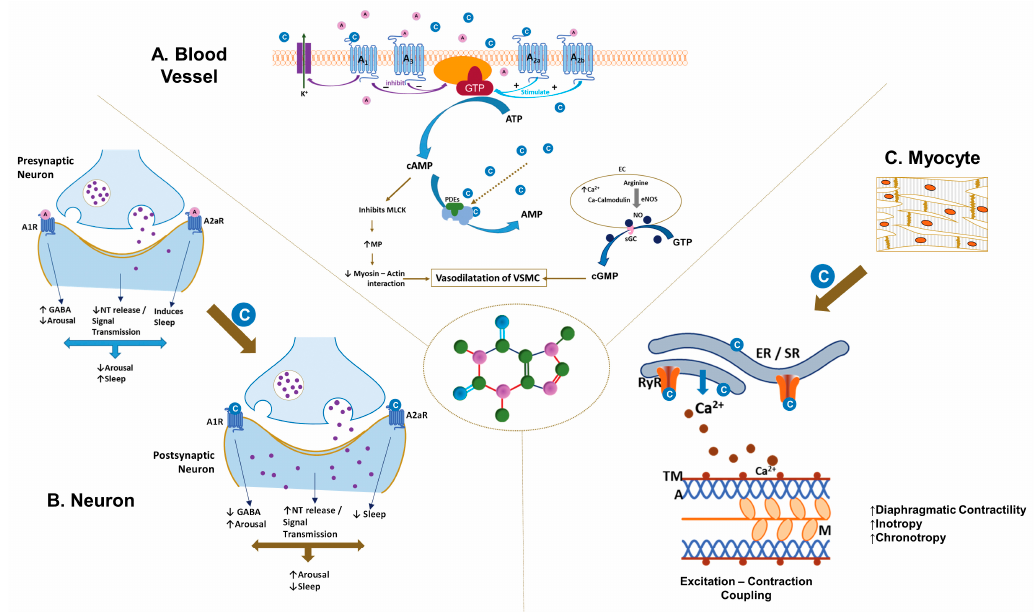
Figure 1. Mechanism of action of caffeine (C 8 H 10 N 4 O 2 ). The illustration depicts the distinct actions of caffeine on ( A ).Blood Vessel, ( B ).Neurons, and ( C ).Myocytes. ( A ).In the vasculature of smooth muscle, caffeine inhibits myosin light-chain kinase via the cAMP pathway and stimulates myosin light-chain phosphatase, inhibiting the myosin-actin interaction. The A 1 /A 3 receptors inhibit cAMP production, whereas A 2a /A 2b receptors stimulate cAMP production by adenylate cyclase. Caffeine increases endothelial cell (EC) Ca 2+ , stimulating endothelial nitric oxide synthase to produce nitric oxide, dilating the vascular smooth muscle cells through the cGMP pathway. ( B ). Caffeine antagonizes the actions of adenosine at the adenosine receptor, specifically at the A 1 /A 2a receptors, resulting in increased wakefulness coupled with altered activity of neurotransmitters such as dopamine, epinephrine, norepinephrine, and serotonin in the nervous system. ( C ). Caffeine mobilizes intracellular calcium by activating the ryanodine receptor on the sarcoplasmic reticulum of skeletal and smooth muscles, facilitating excitation-contraction coupling. A 1 , A 3 , A 2a , and A 2b , adenosine receptors; cAMP-cyclic Adenosine Monophosphate; AC-adenylate cyclase; PDEs-Phosphodiesterase; AMP-adenosine monophosphate; GTP-Guanosine triphosphate; cGMP-cyclic Guanosine Monophosphate; sGC-soluble guanylate cyclase; C-Caffeine molecules; A-Adenosine molecules; ER/SR-Endoplasmic-sarcoplasmic reticulum; TM-tropomyosin; A-actin; M-myosin; ECC-excitation-contraction coupling; NT-neurotransmitters; GABA-gamma-aminobutyric acid (copyright:Vasantha H.S. Kumar, MD).